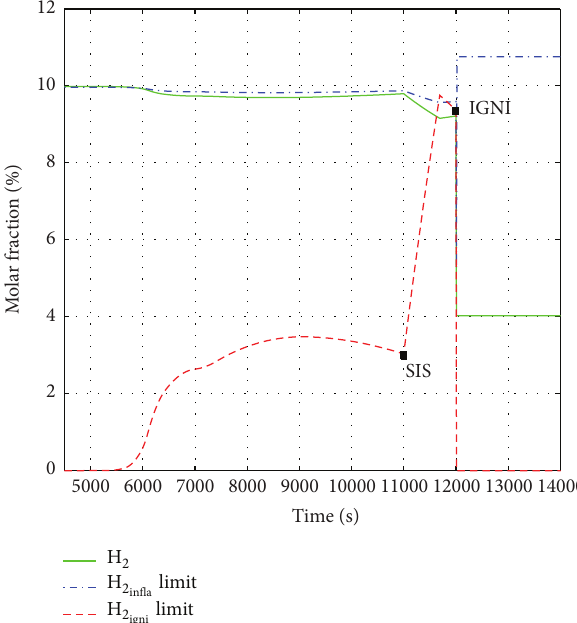
Figure 8: H 2 molar fraction (%) and H 2 inflammability and ignition limits